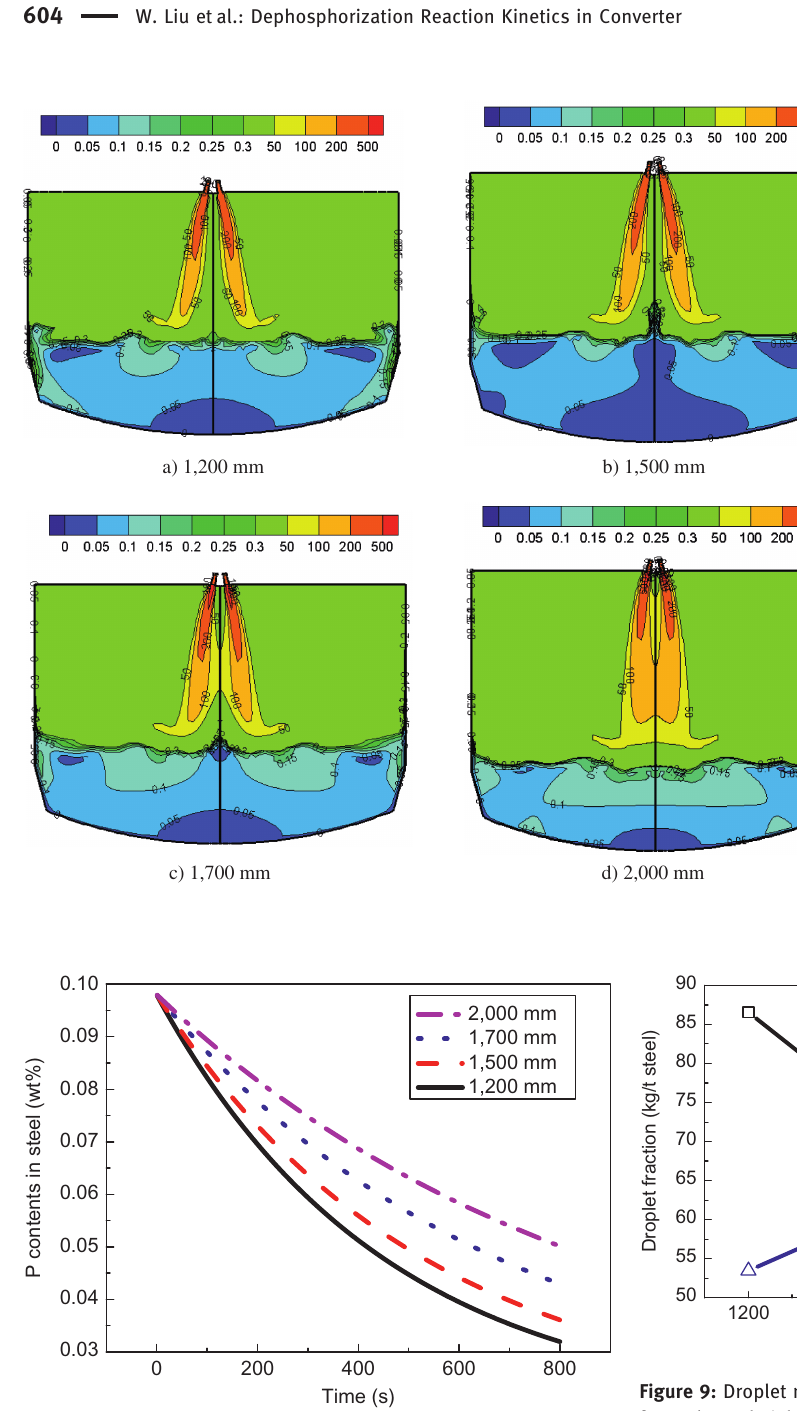
Figure 8: Phosphorus content in steel changing with time at differ- ent lance height.